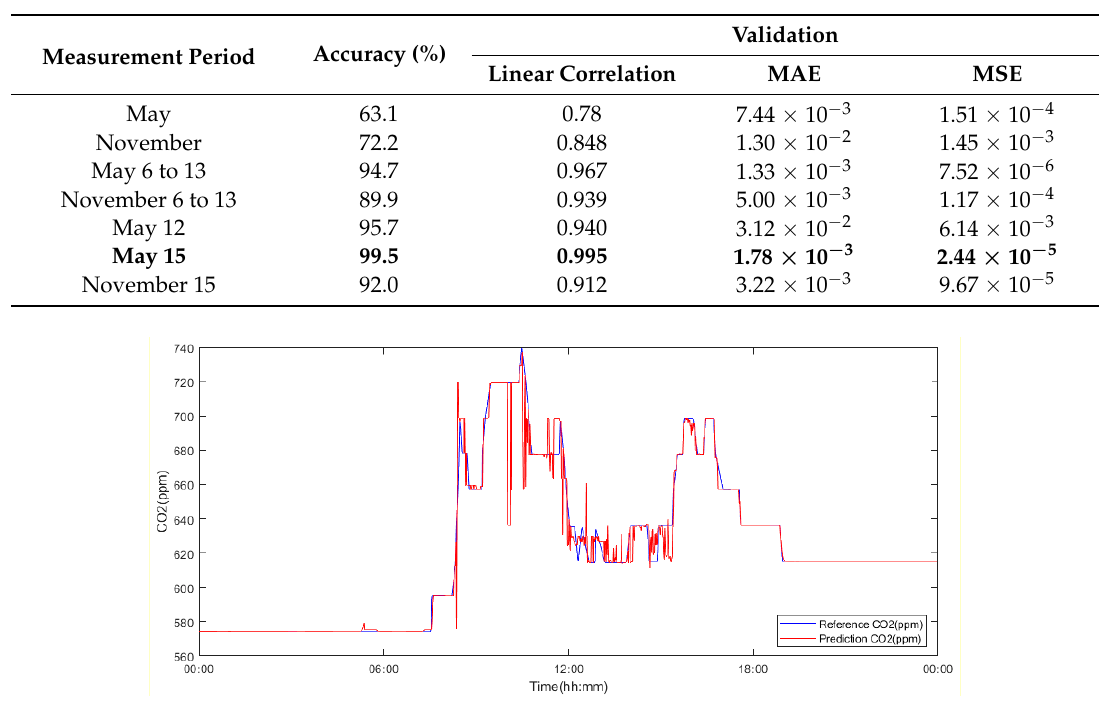
Table 8. The average of the obtained results in each experiment.